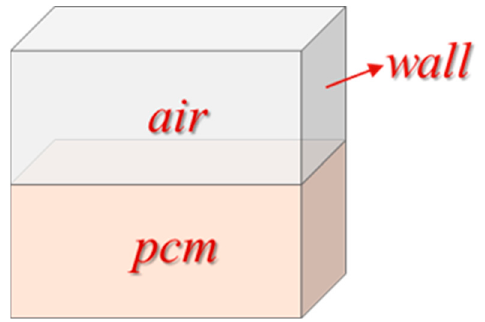
Figure 1. Physical model.